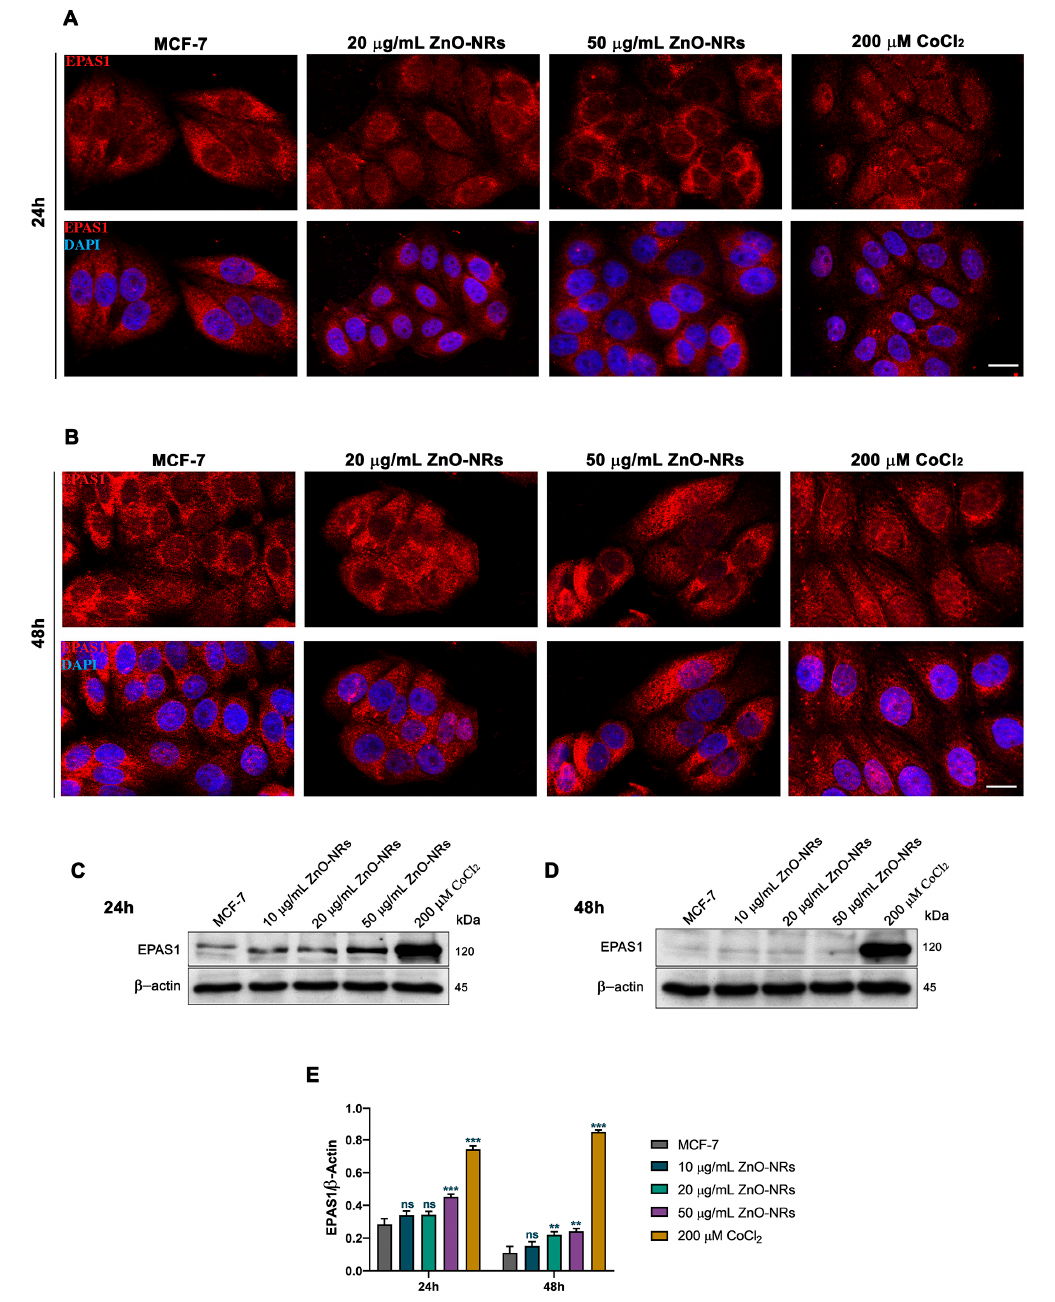
Figure 7. ZnO-NRs’ effects on EPAS1 expression and localization in MCF-7 cells. MCF-7 cells were either untreated or treated with the indicated ZnO-NR concentration for 24 and 48 h. ( A ) EPAS1 nuclear translocation (red fl uorescence) after 24 h treatment with 20 and 50 µg/mL ZnO-NRs. Nuclei were stained with DAPI (blue fl uorescence), 40× magni fi cation. ( B ) EPAS1 nuclear translocation (red fl uorescence) after 48 h treatment with 20 and 50 µg/mL ZnO-NRs. Nuclei were stained with DAPI (blue fl uorescence), 40x magni fi cation. ( C , D ) EPAS1 protein expression after 24 and 48 h treatment with 10, 20, and 50 µg/mL ZnO-NRs. ( E ) Densitometric analysis of EPAS1 protein expression after 24 and 48 h treatment with 10, 20, and 50 µg/mL ZnO-NRs. Experiments were repeated three times. ** p < 0.01, and *** p < 0.001. ns, not signi fi cant. In all experiments, hypoxia, induced by 200 µM CoCl 2 , was used as positive control. β -actin was used as loading control.